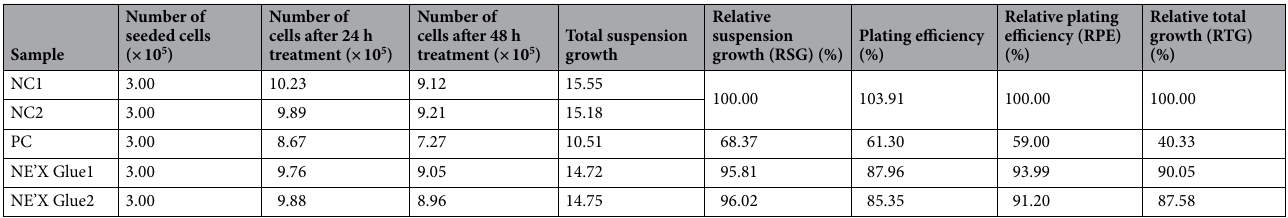
Table 7. Toxicity data, metabolic activation, 4 h exposure. PC positive control, NC negative control.